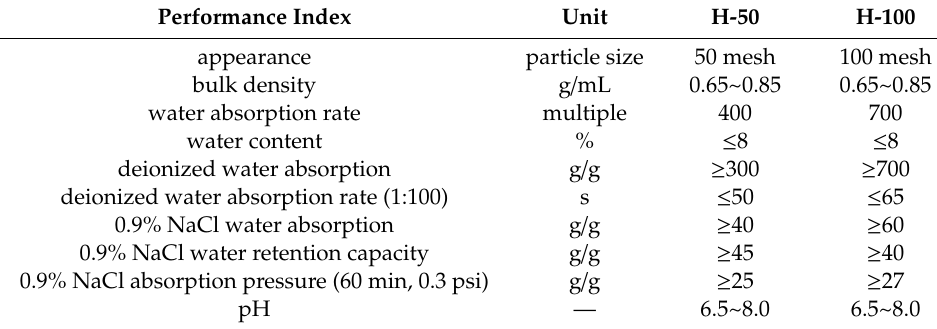
Table 1. Performance index of SAP for